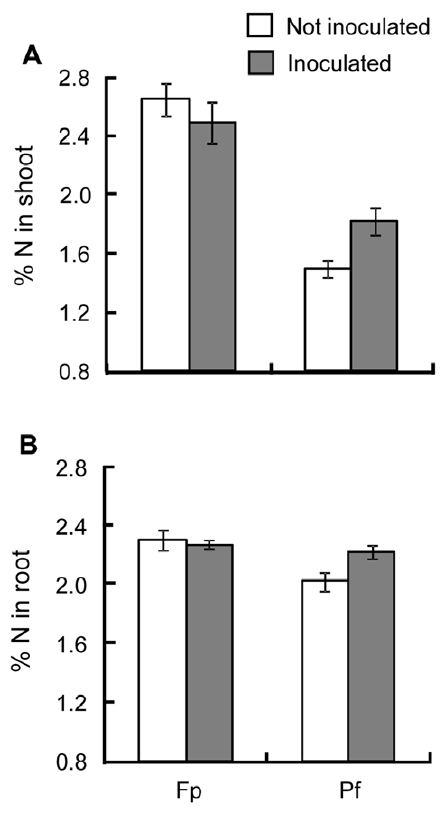
Figure 3. Average percentage of Nitrogen in Medicagotrunca- tula shoot and root. Average percentage of Nitrogen in the shoot (A) and the root (B) depends on the developmental stage (Fp, Pf, see text) and the condition of inoculation (Inoculated or not with Pseudomonas fluorescens C7R12). The percentage of N, measured during the second experiment replicate only, was analysed by linear model with condition of inoculation, CO 2 concentration and developmental stage as fixed factors and with their interactions. Standard errors are represented by vertical bars.